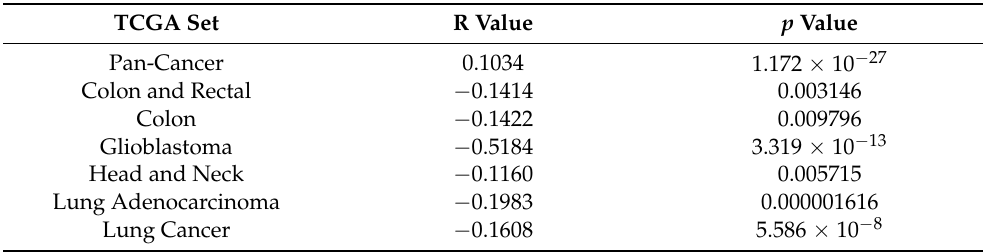
Table 1. Comparison of UBA1 and NEDD8 expression in different TCGA samples sets. The regression analysis and statistical significance are